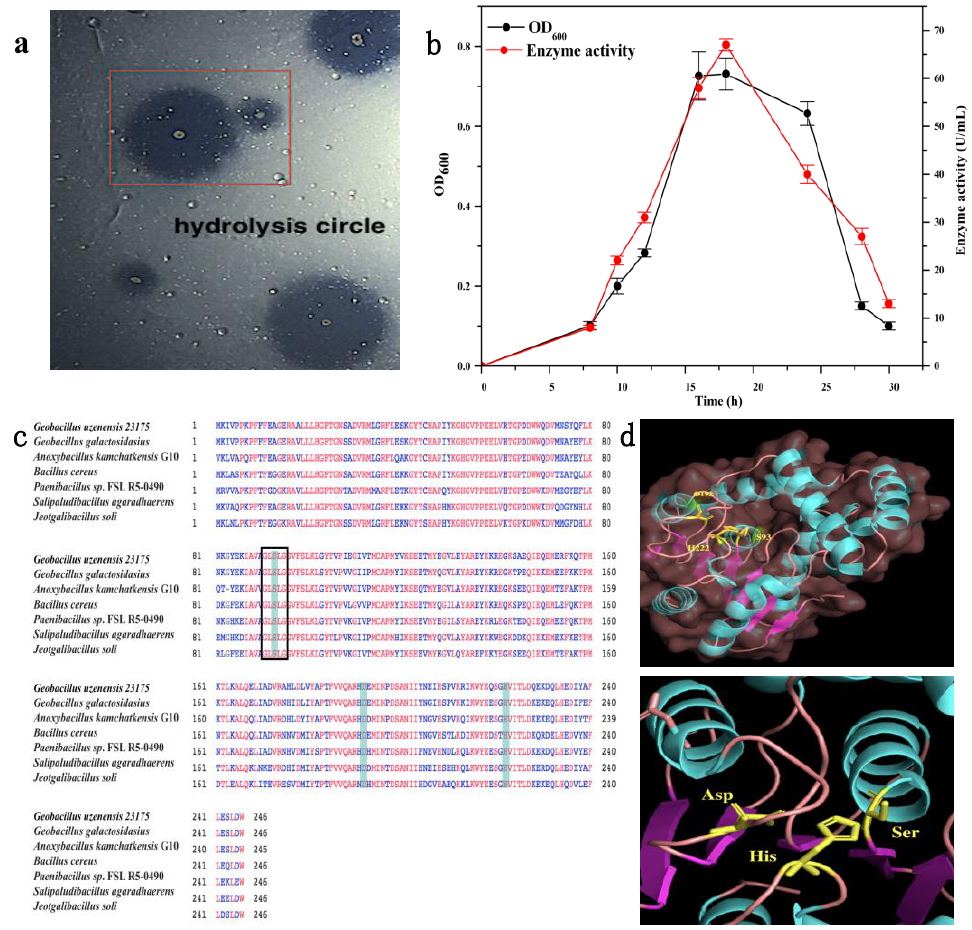
Figure 1. Screening and fermentation of wild type bacteria, gene analysis and molecular structure modeling of Est 741 . ( a ) Hydrolysis circle on esterase screening culture. ( b ) Enzyme activity and OD 600 of the fermentation broth of the wild type bacteria. ( c ) Multiple sequence alignment between Est 741 and other closely related enzymes. The catalytic active sites are marked in blue, and the conserved region, GLSLG (Gly-Leu-Ser-Leu-Gly) is boxed. ( d ) 3D model of Est 741 was predicted by SWISS-MODEL (A fully automated protein structure homology-modelling server).